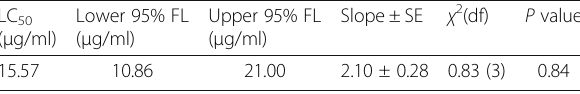
Table 1 The calculated LC 50 of AMEP412 against B. tabaci